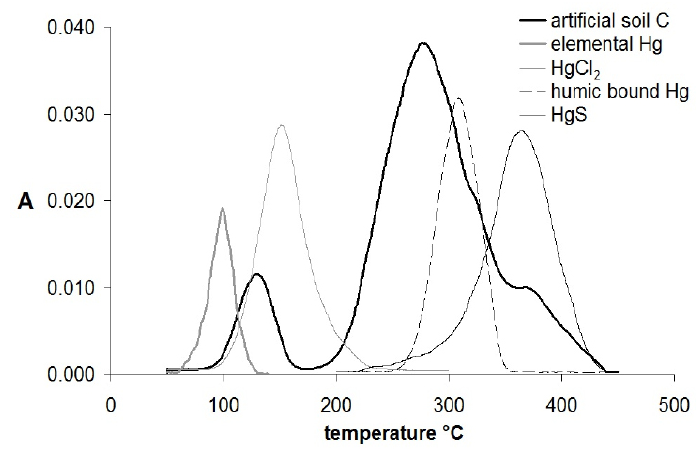
Figure 3. Mercury release curves of pure chemicals and artificial soil C.